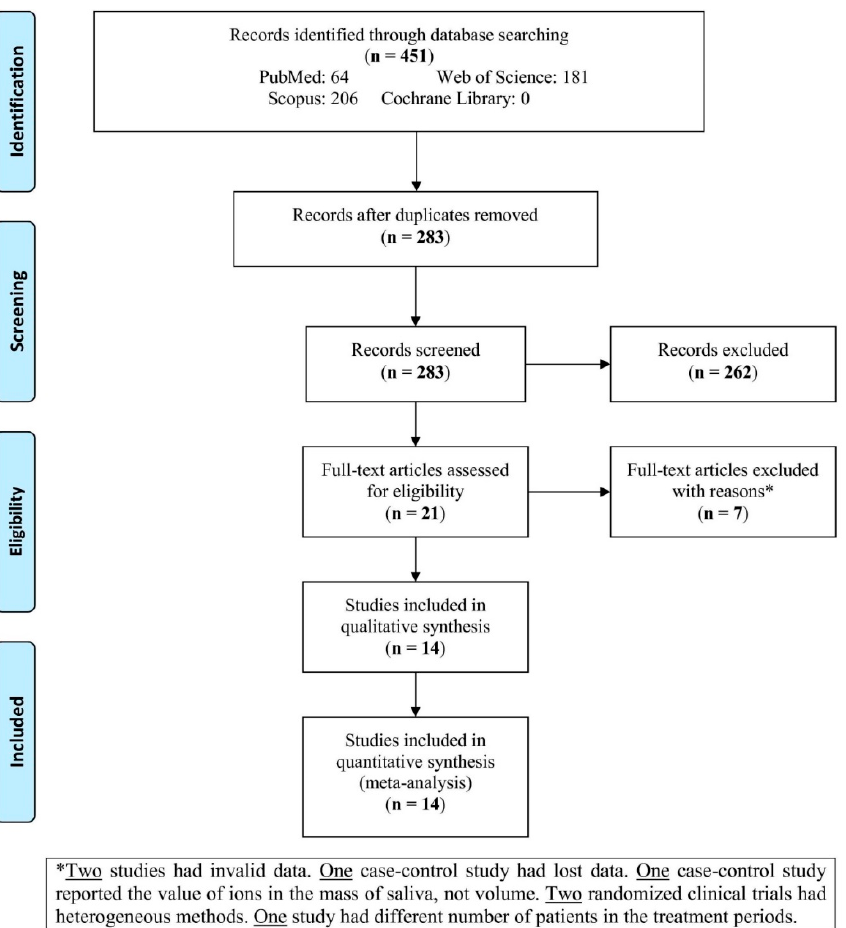
F igure 1. Flowchart of literature search and study selection. Figure 1. Flowchart of literature search and study